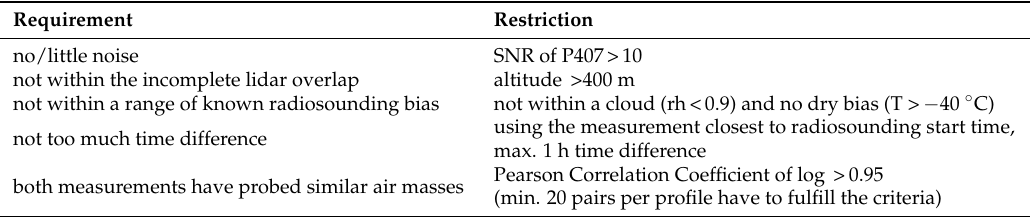
Table 1. Requirements for data to be elected for